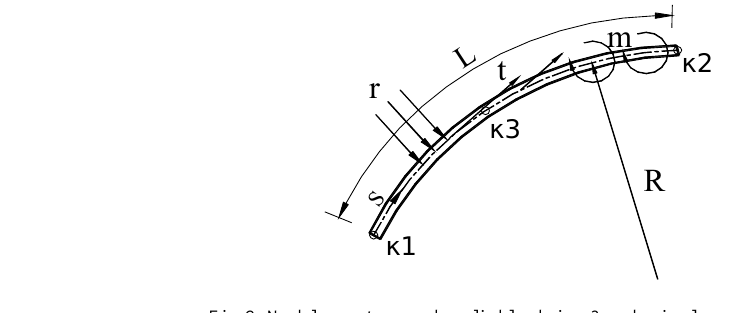
Fig. 2. Nodal curvatures and applied loads in a 3-node circular arch